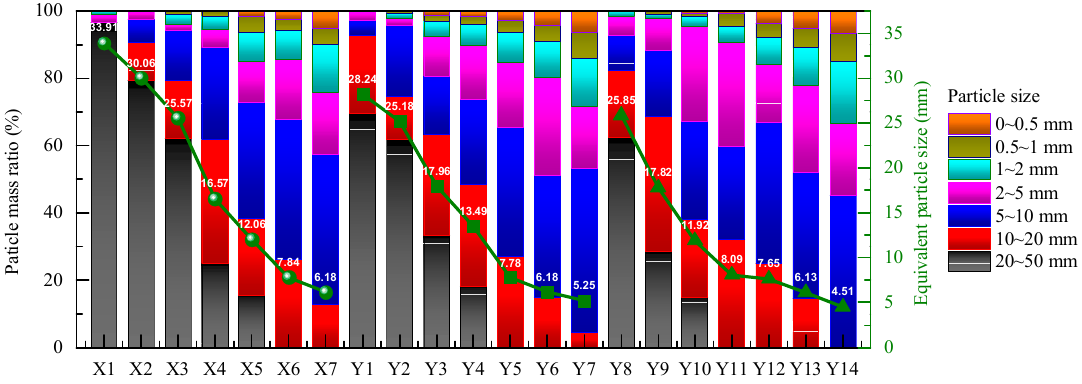
Figure 7. Particle mass ratio and equivalent particle size of crushed coal under uniaxial compressive SHPB tests—specimens X1–X7 are for Xinzhouyao coal (resistant), and specimens Y1–Y14 are for Xintian coal (prone).